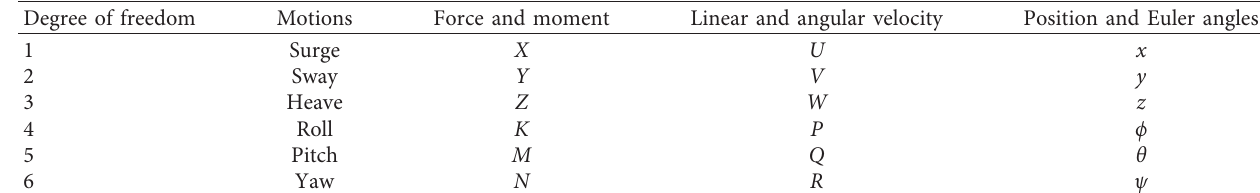
Table 1: SNAME notations for underwater